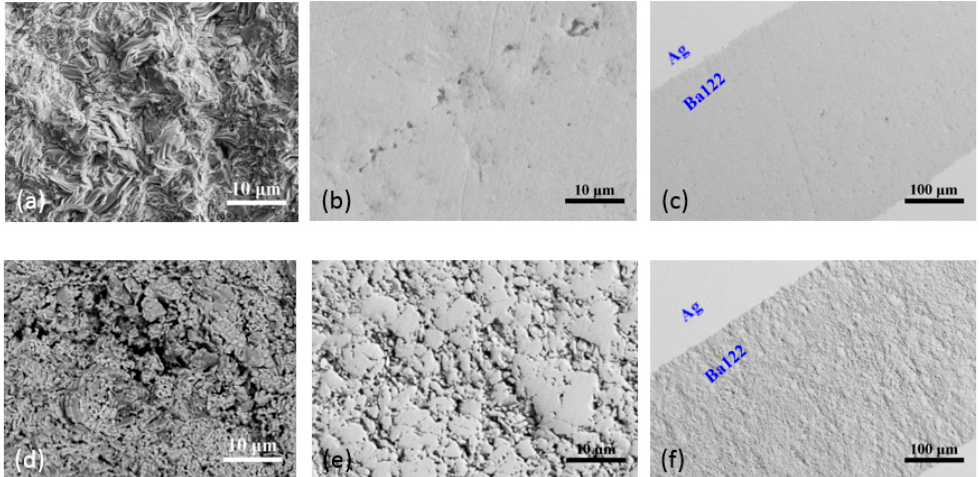
Figure 12. SEM and microscope images of ( a – c ) HIP-processed samples and ( d – f ) ambient pressure- sintered sample at different magnifications [56]. Adapted with permission from Ref. [56]. 2021, Shifa Liu.